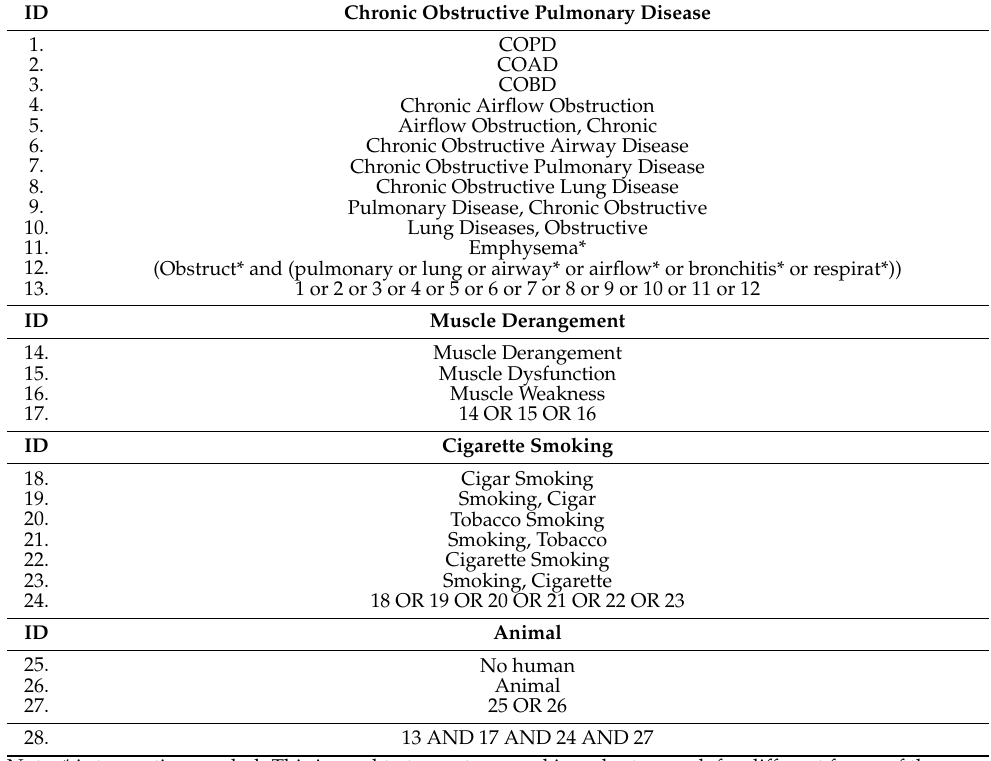
Table 1. Search strategy and